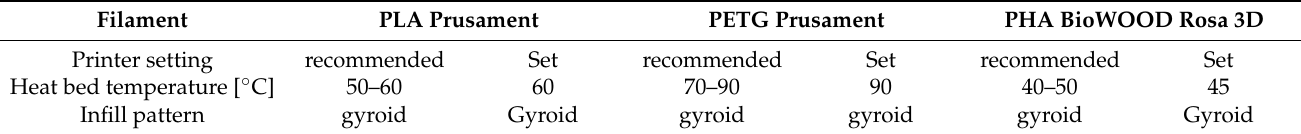
Table 2. Printer settings for parameters that did not change in the